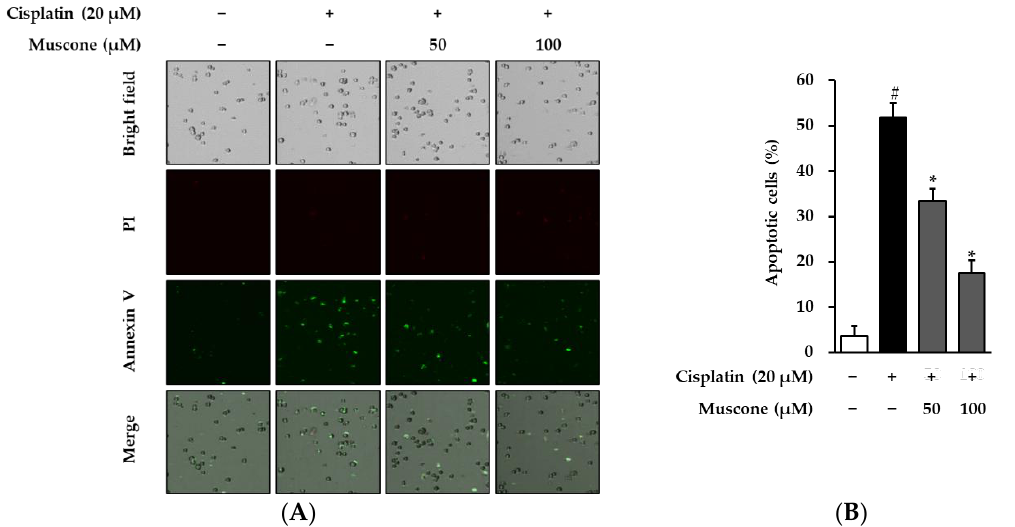
Figure 6. Protective effect of muscone against cisplatin induced apoptosis in kidney proximal tubule LLC-PK1 cells. ( A ) LLC-PK1 cells were exposed to indicated concentrations of muscone in the presence or absence of 20 µM cisplatin for 8 h and dyed with propidium iodide (PI) and Alexa Fluor 488-conjugated annexin V. ( B ) The bar chart depicts the percentage of apoptotic cell (annexin V-positive cells) quantified from images obtained using TaliPCApp. The data are described as the mean ± SD ( N = 2). Notes: # p < 0.05 compared with the non-treated group, * p < 0.05 compared with the cisplatin treated group.